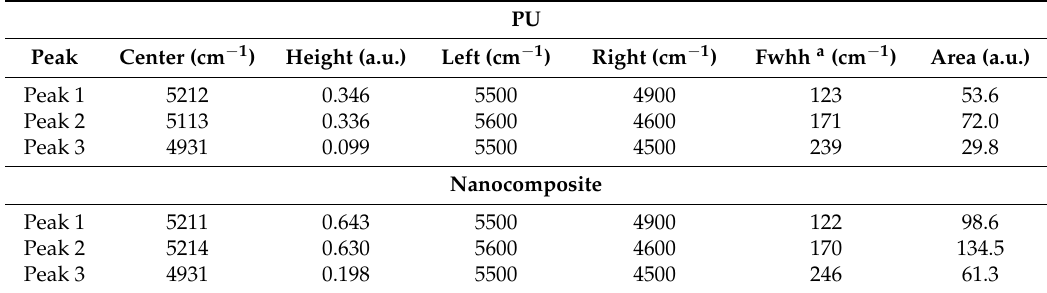
Table 2. Results of the Curve-Fitting Analysis of the Spectra of Water absorbed by plain PU and its